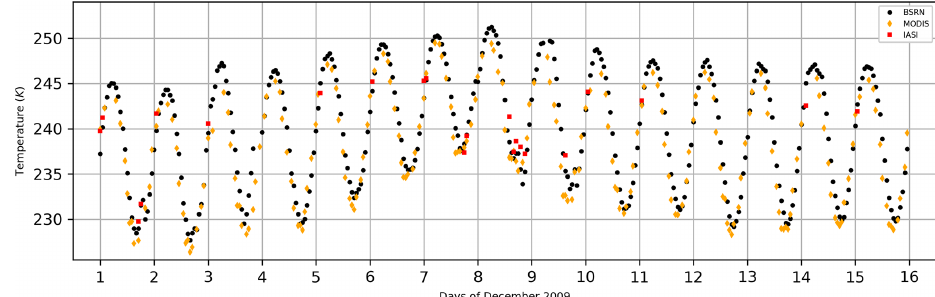
Figure 2. BSRN (black dots), MODIS (orange diamonds), and IASI (red squares) observation of surface temperature.